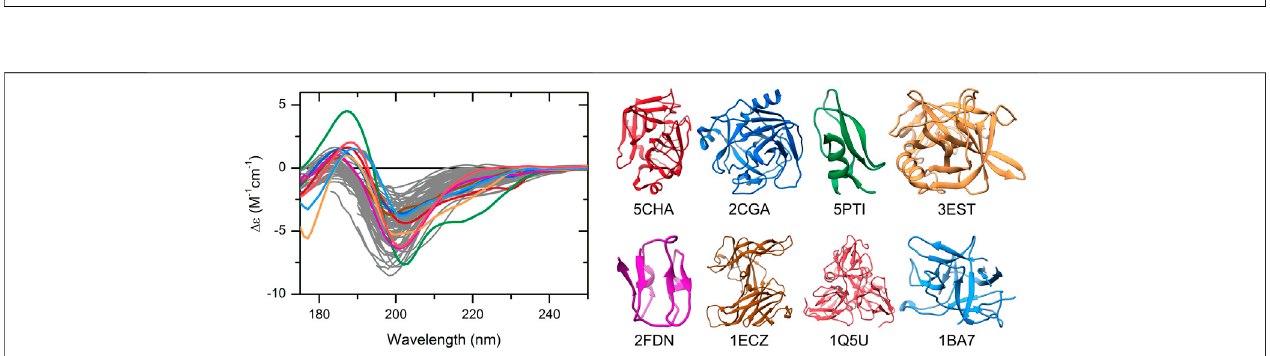
FIGURE 1 | 2D-plot of CD data of IDPs and ordered proteins. (A) Mean residue ellipticities at 200 and 222 nm wavelengths for IDPs (yellow) and globular proteins (light blue) were collected from the literature for proteins previously studied by Uversky (2002), Uversky (2003), Uversky and Fink (2004). “ Random coil ” and “ premolten globule ” typesofIDPswerenotdistinguishedinourwork. (B) Plotofthefullreferencedatabase.IDPsovertheonespresentedin (A) areshowninred,whiletheadditional globular ones are shown in dark blue. Hollow circles show those proteins that are incorrectly classi fi ed as disordered or ordered by using the 200 and 222 nm wavelength data of proteins presented in panel A as training set for disordered – ordered classi fi cation (see later). Note the large spectral (and conformational) space covered by the ordered proteins.